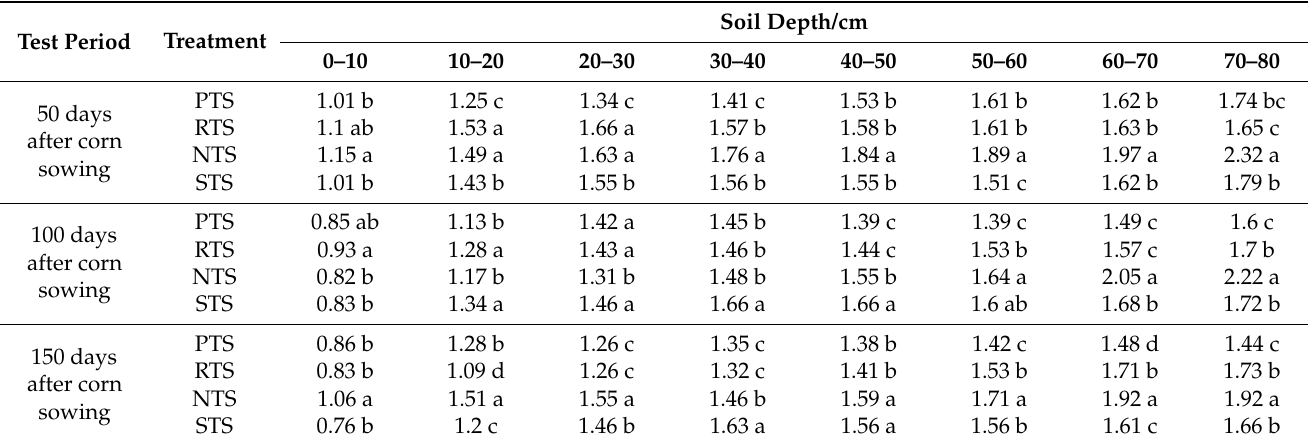
Table 3. Significance analysis of soil penetration